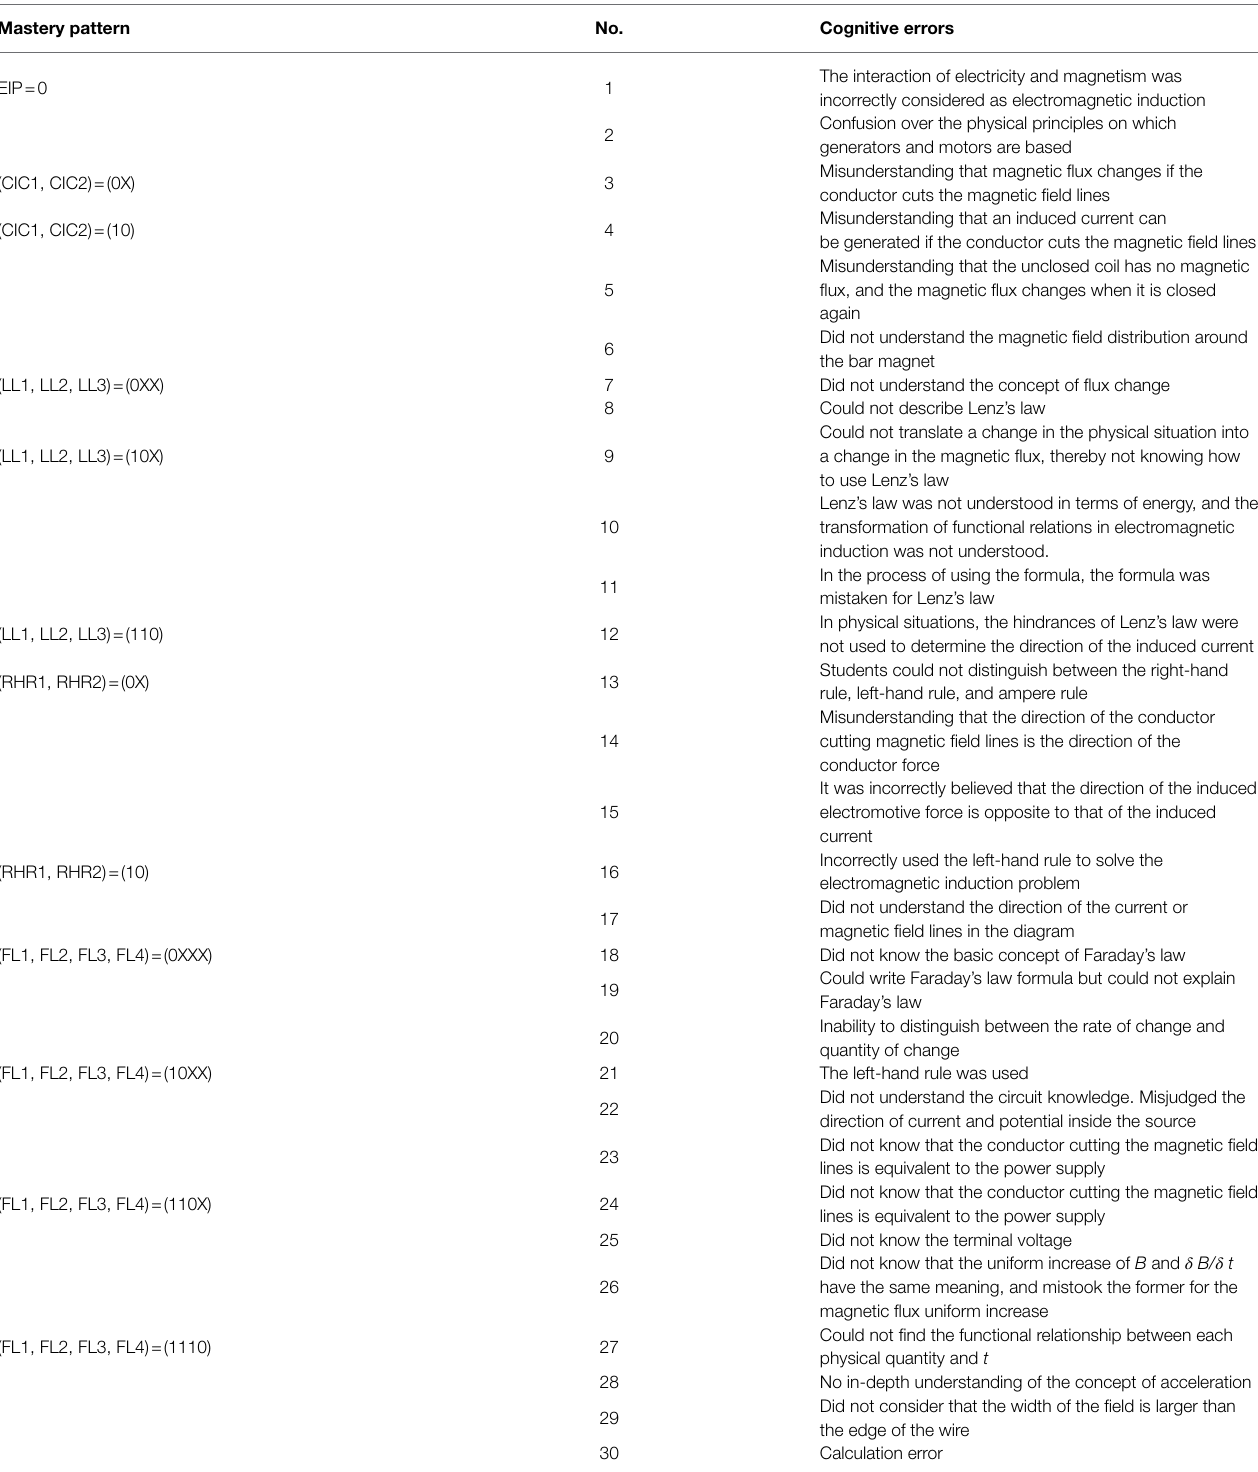
TABLE 2 | The cognitive errors of each mastery pattern classification. Mastery pattern No. Cognitive